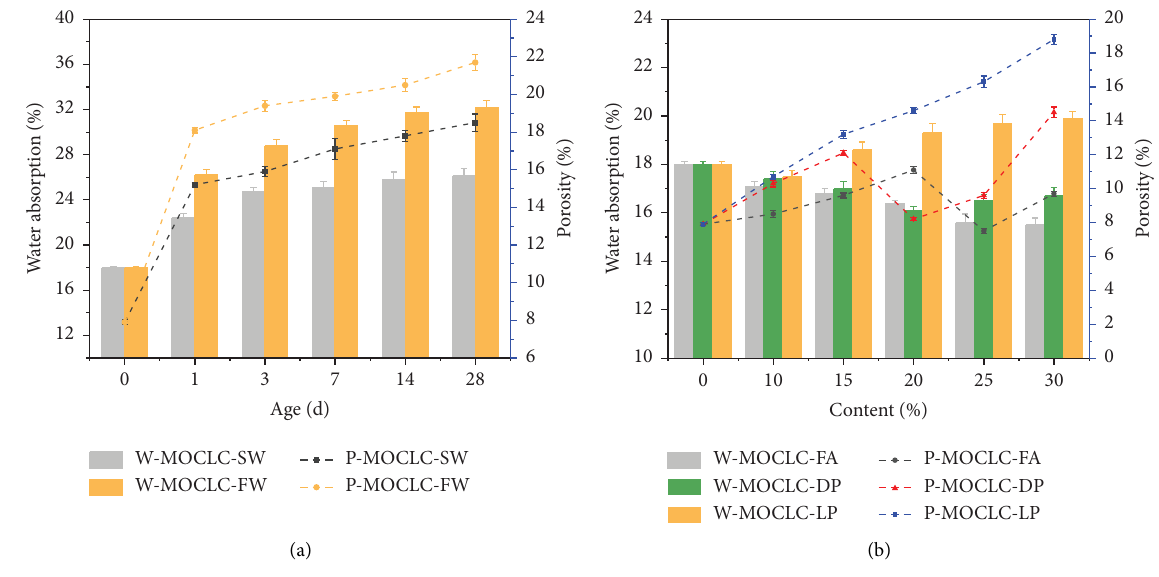
Figure 11: Water absorption and porosity of MOCLC.